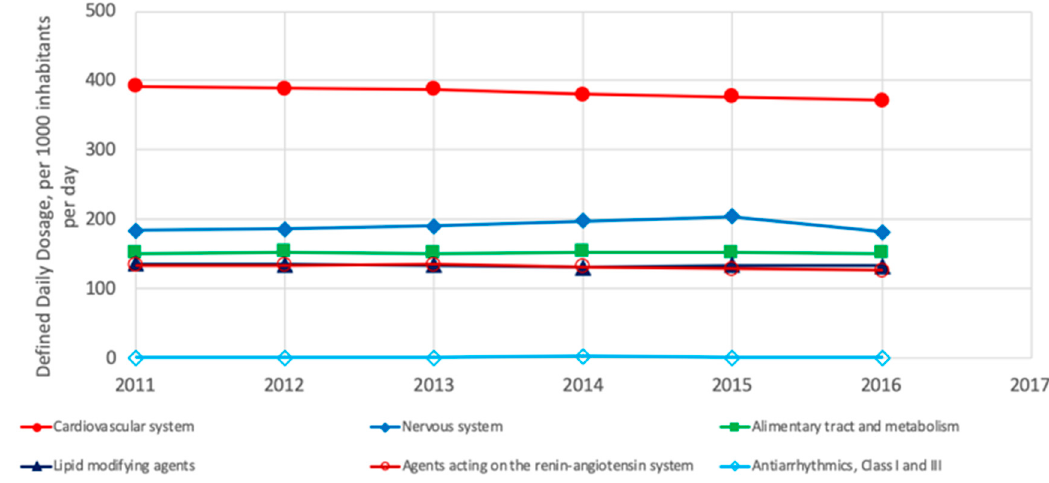
Figure 14. Most consumed pharmaceuticals in Australia and New Zeeland between 2011 and 2017 [3].